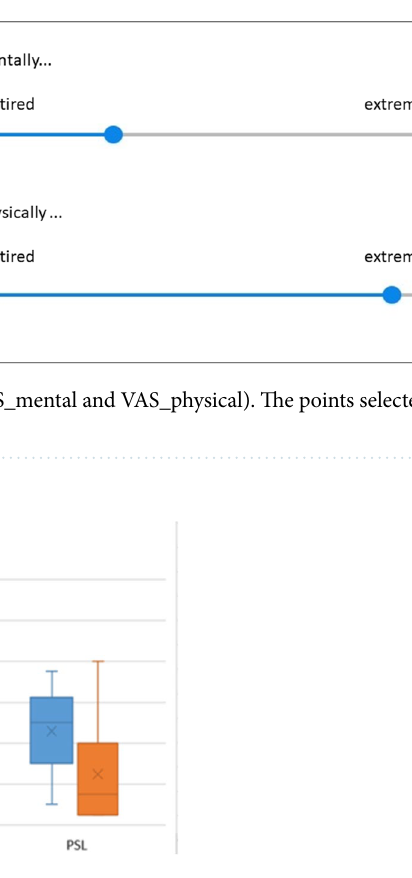
Figure 6. Boxplot with VAS_mental and VAS_Physical distributions with the minimum and maximum values, median, quartiles 1 and 3 and outlier values. Asterisks indicate significant comparisons ( p <